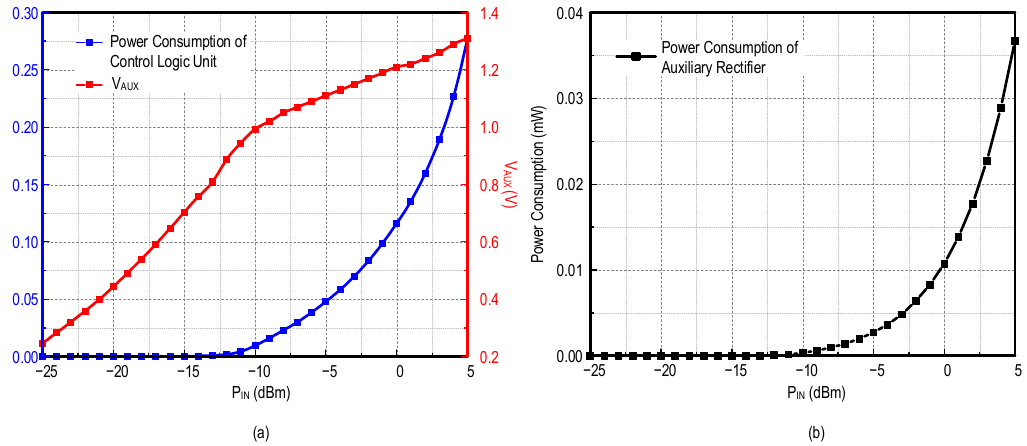
Figure 16a depicted the relationship of P IN , V AUX , and the power consumption of the control logic unit. V AUX increases linearly with the increment in P IN due to the boosting effect of the two-stage auxiliary rectifier. The power consumption of the control logic unit increases exponentially with the increment in P IN . This is because V AUX , which is the source of the control logic unit, is increased, causing more power to flow into the control logic unit. The power consumption of the control logic unit is negligible as P IN is lower than − 10 dBm and its power consumption increases with the P IN and reaches a peak consumption of 0.278 mW at 5 dBm. Figure 16b shows the power consumption of the auxiliary rectifier. It shows a similar behavior where the power consumption is negligible when P IN is below − 10 dBm and it increases exponentially until a peak consumption of 0.037 mW at 5 dBm. Figure 16. ( a ) The relationship between the input power, auxiliary rectifier’s output voltage, and the power consumption of the control logic unit. ( b ) The power consumption of the auxiliary